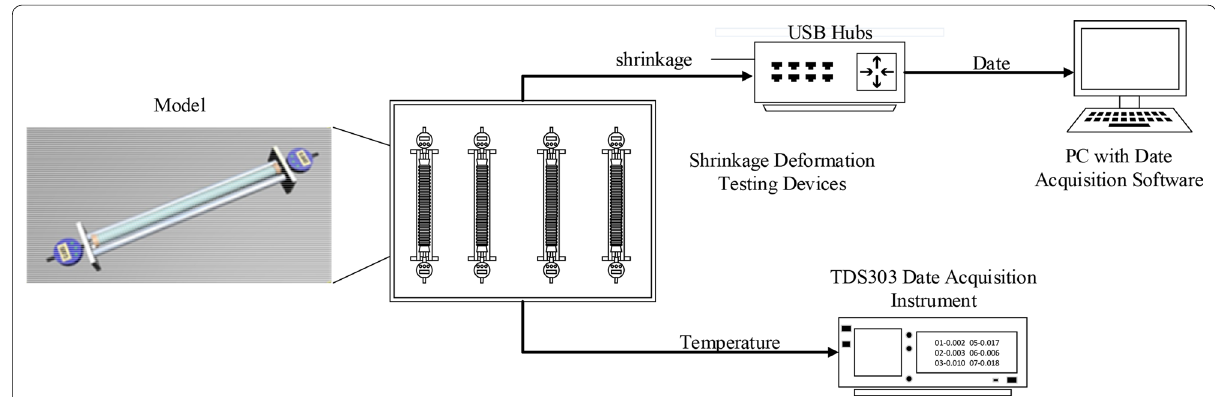
Fig. 2 Bellows testing device.